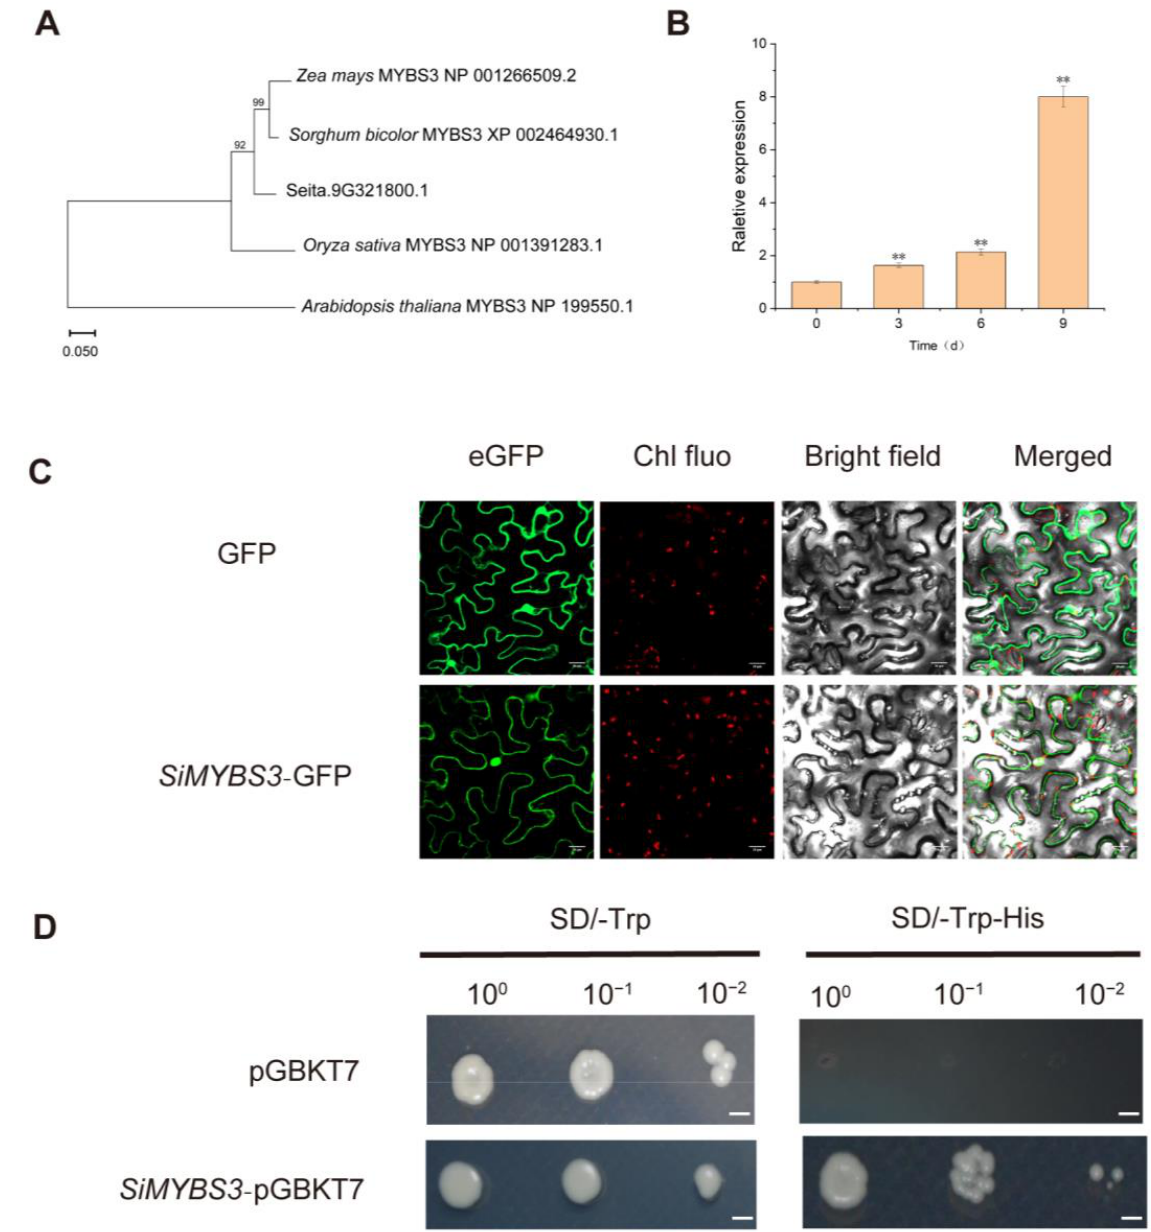
Figure 4. Phylogenetic relationship, expression patterns, subcellular localization, and transactivation assay of SiMYBS3. ( A ) Phylogenetic relationship of SiMYBS3 and other plant MYBS3 members. The accession numbers for different plants are: NP_001391283.1 ( Oryza sativa MYBS3), NP_001266509.2 ( Zea mays MYBS3), XP_002464930.1 (Sorghum bicolor MYBS3), and NP_199550.1 ( Arabidopsis thaliana MYBS3). The numbers at the nodes indicate the bootstrap values. ( B ) Expression levels of SiMYBS3 under drought stress at different time points. ( C ) Subcellular localization of SiMYBS3 in tobacco leaf cells. The fusion construct ( SiMYBS3 ::GFP) was transiently expressed in tobacco epidermal cells. Empty vector (GFP) was used as control. Bar, 20 µ m. ( D ) Transactivation assay of SiMYBS3. Transformed yeast cells were screened on SD/-Trp and SD/-Trp-His media. Bar, 0.2 cm. The histogram represents mean ± SD of three biological replicates. Student’s t -tests: ** p ≤ 0.01.